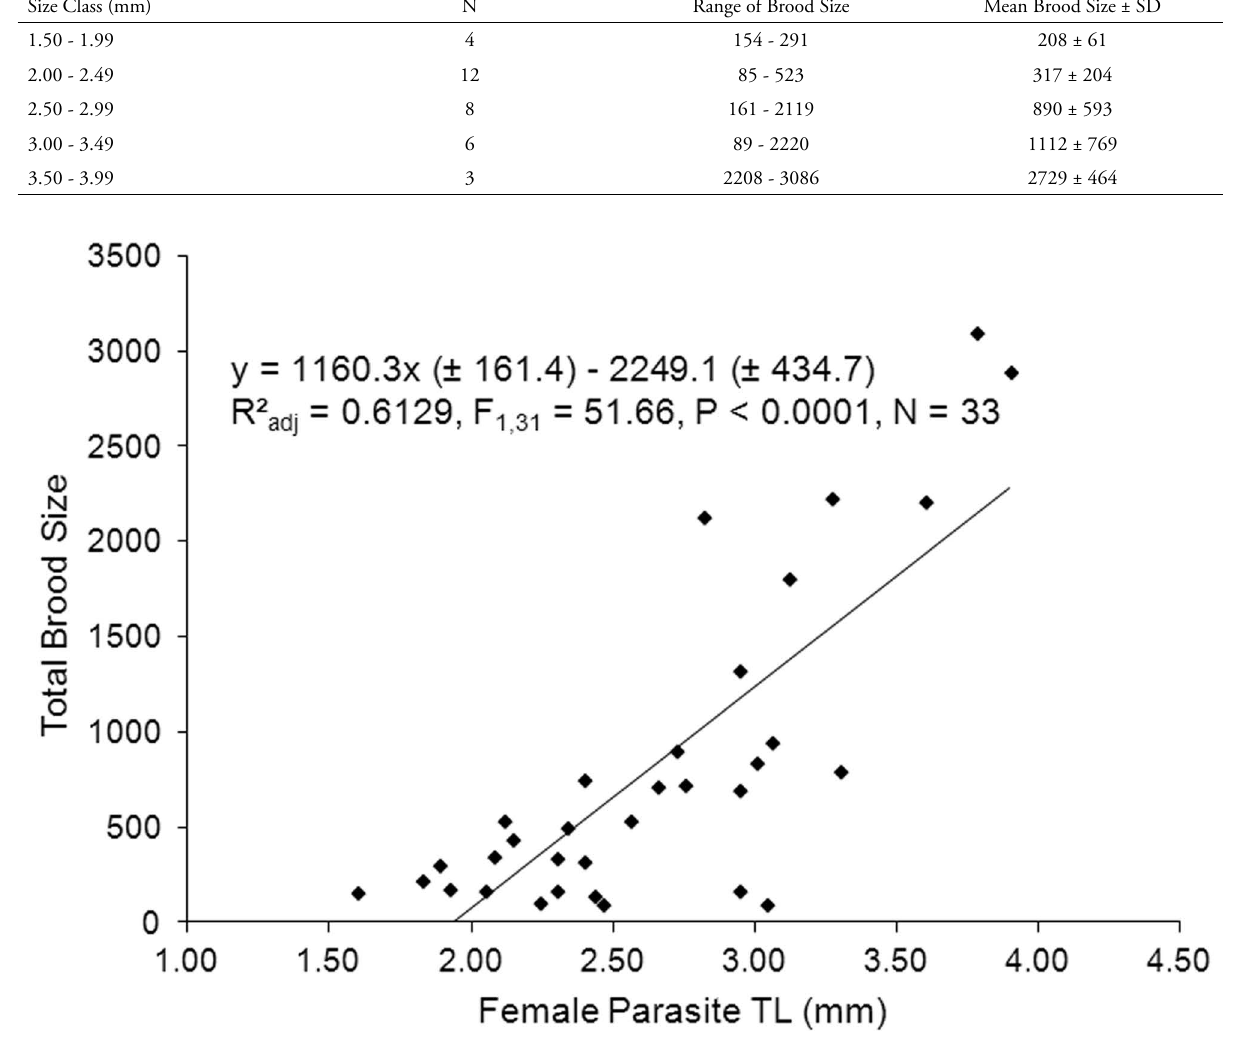
Figure 6. Urobopyrus processae . Variation in number of embryos in a brood as explained by female total length (TL, in